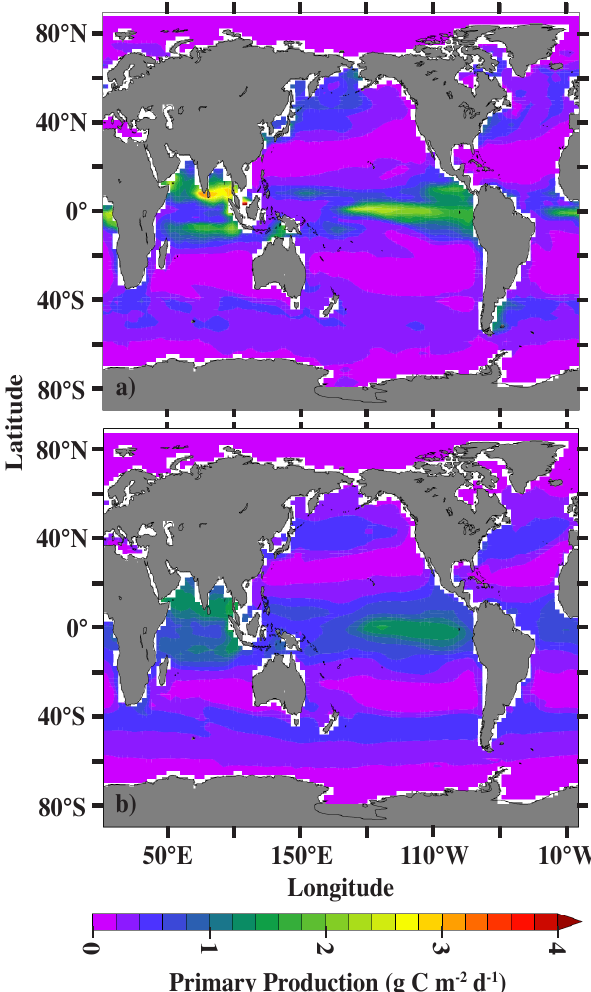
Fig. 14. Annual vertically integrated rates of primary production with the (a) new and (b) old model